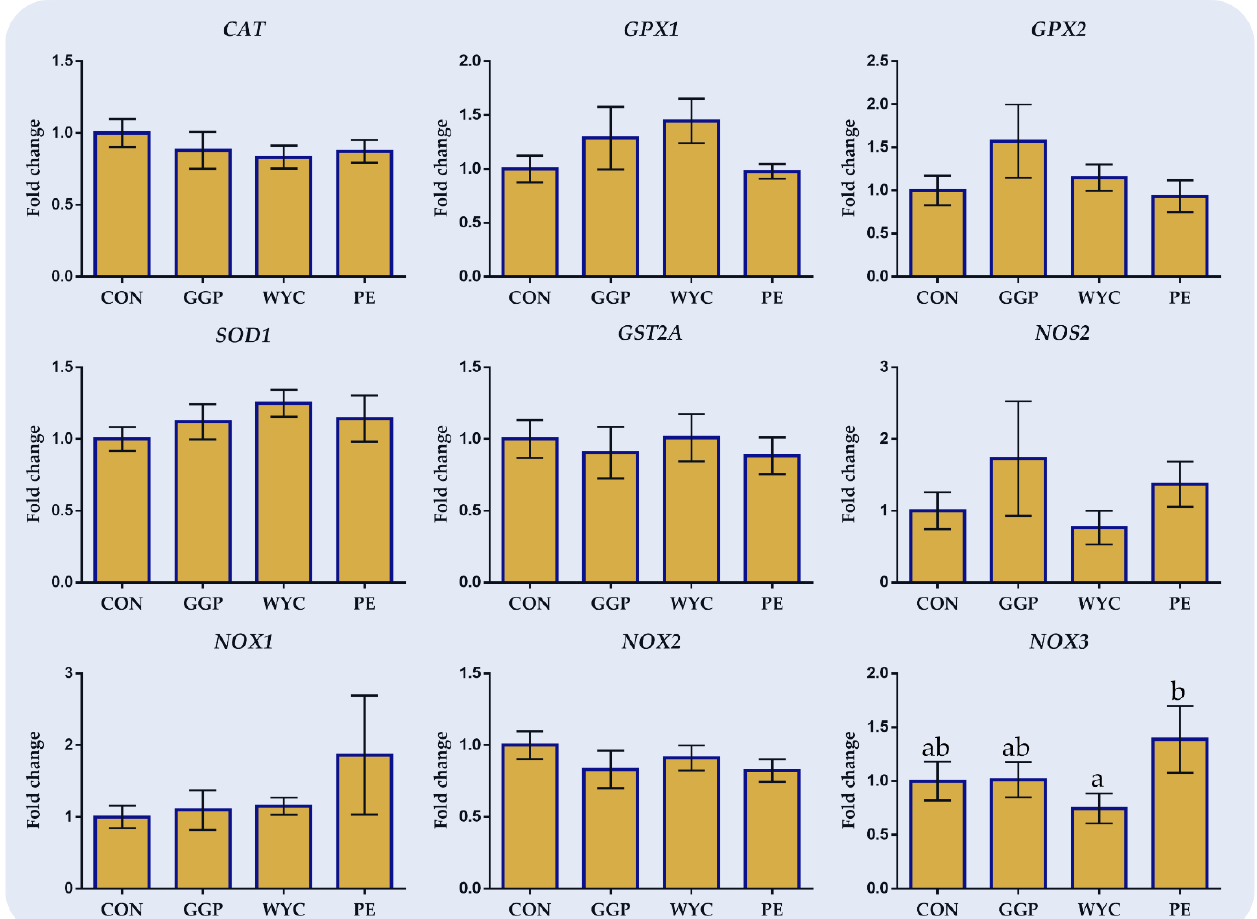
Figure 2. Mean and standard error of means (SEM) of relative transcript levels as fold changes of several genes involved in the antioxidant system in the liver of broilers fed the four experimental diets (Control; CON, ground grape pomace; GGP, dried wine lees; WYC, and extract from grape stems included in soluble starch; PE). Bars with different superscript (a, b) between dietary treatments differ significantly ( p ≤ 0.05) according to the analysis of variance (ANOVA) using post hoc multiple range test when appropriate.